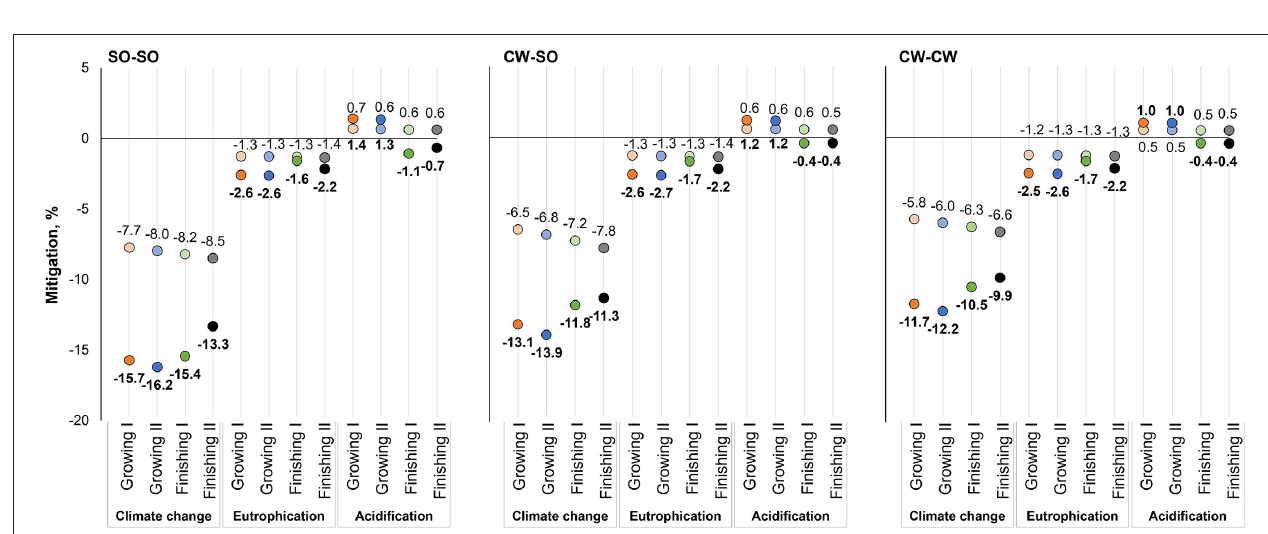
FIGURE 2 | Potential environmental impact mitigation associated with the production of piglet feeds, considering energy savings from an energy matrix of 90 kcal of ME/kg of feed released by β -mannanase supplementation in different grain production scenarios; SO-SO, Soybean and corn produced in Southern Brazil; CW-SO, Soybean produced in Central-West Brazil and corn produced in Southern Brazil; CW-CW, Soybean and corn produced in Central-West Brazil.